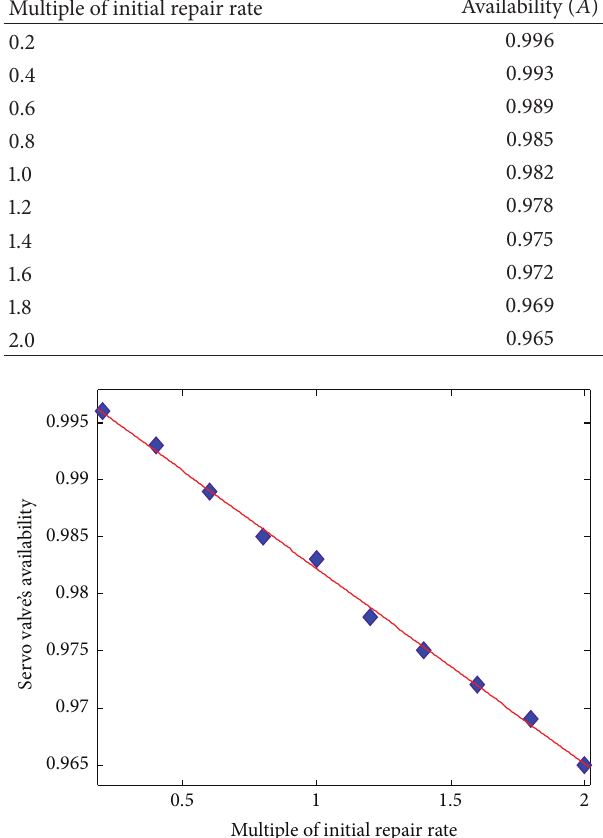
Figure 5: The relationship curve between servo valve’s availability and multiple of initial repair